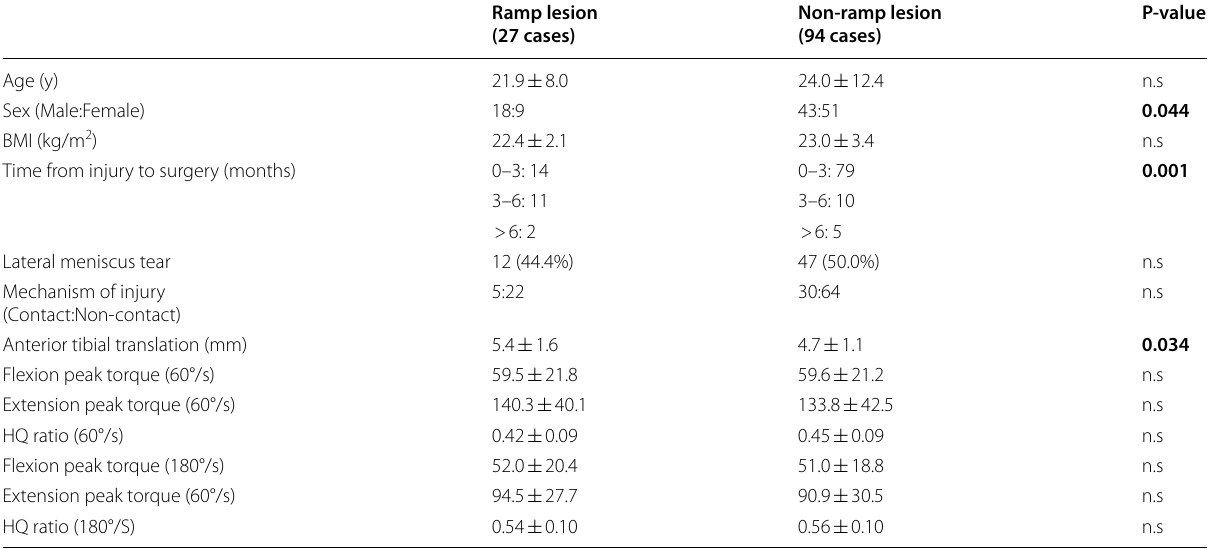
BMI body mass index, HQ hamstrings strength-to-quadriceps strength, n.s ., not significant